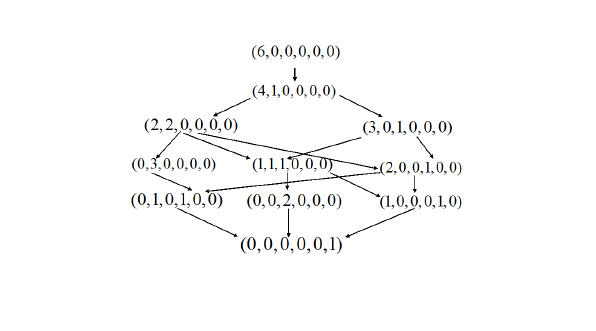
Figure 1. State space obtained from the initial condition P( 6 , 0 , 0 , 0 , 0 , 0 ; 0 ) = 1 with the constraint